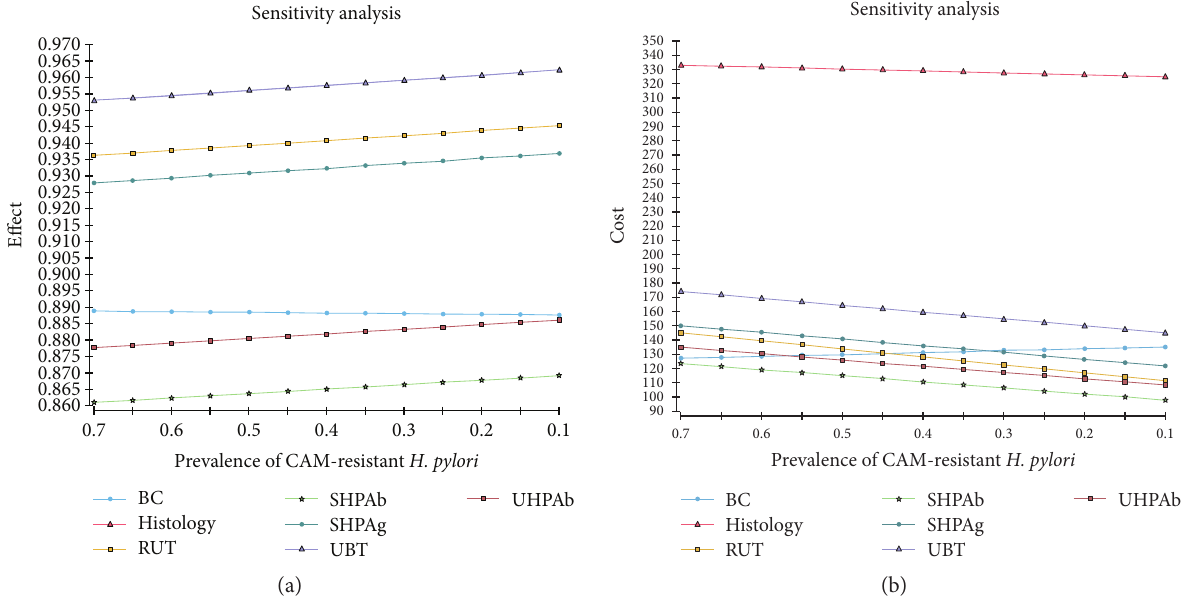
Figure 3: One-way sensitivity analysis. Sensitivity analysis using prevalence of clarithromycin- (CAM-) resistant Helicobacter pylori (H. pylori) showed that the order of e ff ectiveness of seven diagnostic methods did not change between a CAM-resistant H. pylori prevalence of 0.1 and 0.7. The lines of histology and urea breath test were overlapped (a). In contrast, the cost of bacterial culture became equal to urine H. pylori antibody or rapid urease test or stool H. pylori antigen at between a CAM-resistant H. pylori prevalence of 0.3 and 0.58 (b).